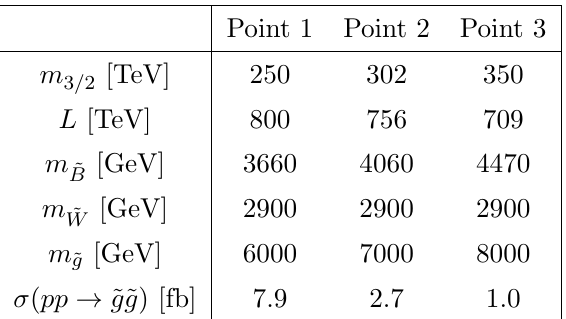
Table 1 . Fundamental parameters ( m and L ), gaugino masses, and the gluino pair production 3 = 2 cross section (for the centre-of-mass of 100 TeV), for Sample Points 1, 2, and 3. in the present framework, the mass splitting is dominantly via radiative correction due to loop diagrams with electroweak gauge bosons [10, 11], and the neutral Wino becomes lighter than the charged one. Based on the two-loop calculation, the mass splitting